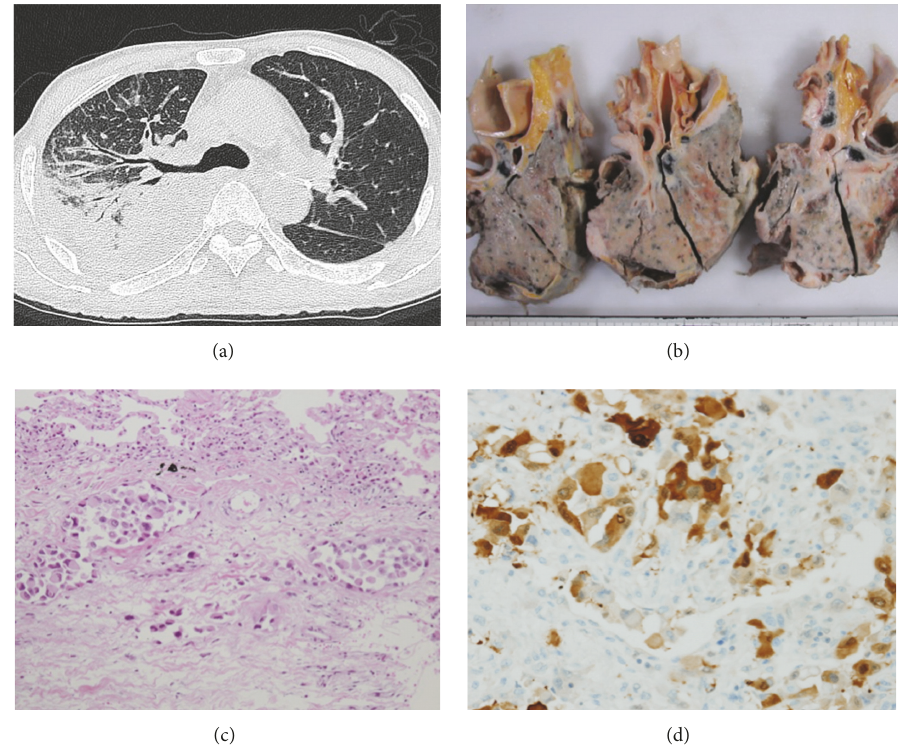
Figure 1: (a) An axial high-resolution chest CT scan showed extensive bronchovascular bundle and septal thickening and a consolidative mass in the upper lobe of the right lung; these findings are consistent with the lymphangitic spread of the tumor. (b) The gross pathological findings of the lung and pleura at autopsy showing multiple pleural nodules and masses on the pleural surface. The lung parenchyma is encased by tumor growth and the lymphatic spread of the tumor is observed. (c) Light microscopy of the resected pleural tumor. The lesion was histologically diagnosed as epithelioid-type malignant pleural mesothelioma. The marked invasion of the lymphatic vessel by tumor cells was observed (hematoxylin and eosin staining, × 100). (d) On immunohistochemical staining, the tumor cells were positive for calretinin, a mesothelial cell